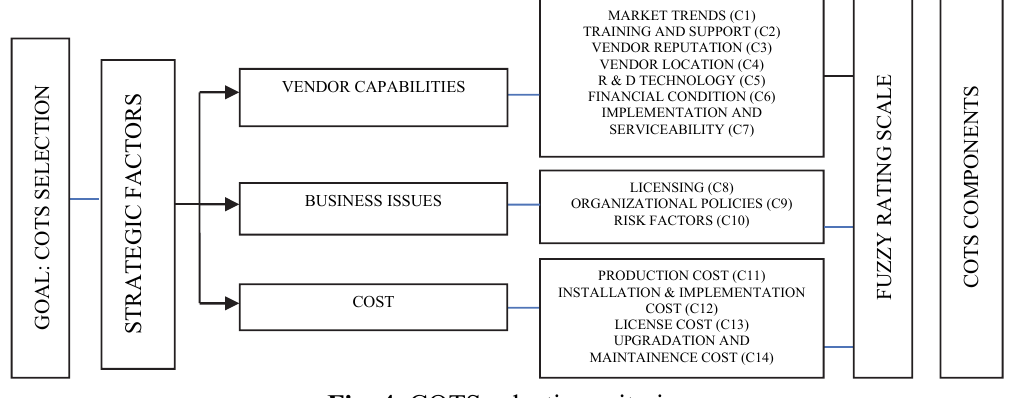
Fig. 4. COTS selection